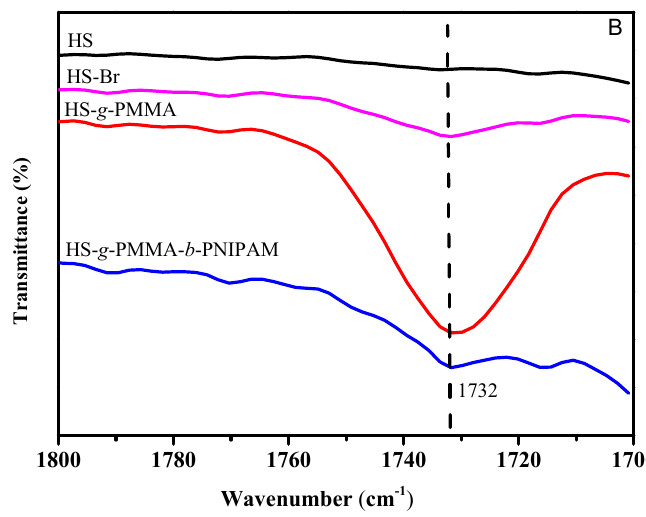
Figure 2. Fourier transform infrared spectroscopy (FT-IR) spectra ( A ) and magnified FT-IR spectra in